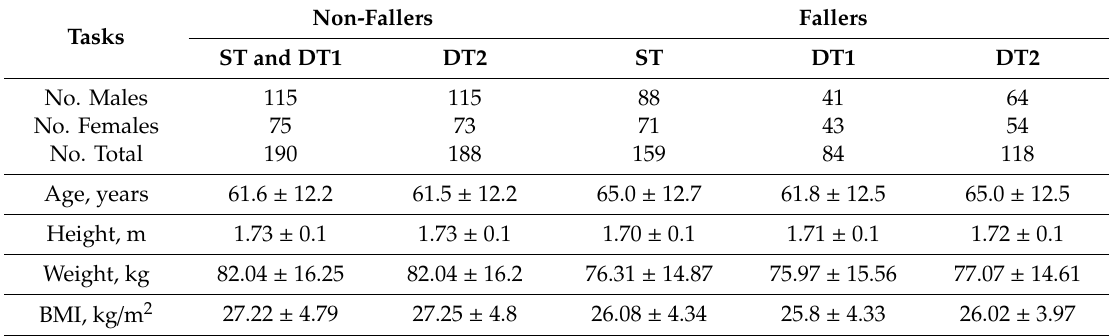
Table 1. Demographics of participants for the single task (ST) a motor dual tasks (DT1) and a cognitive dual task